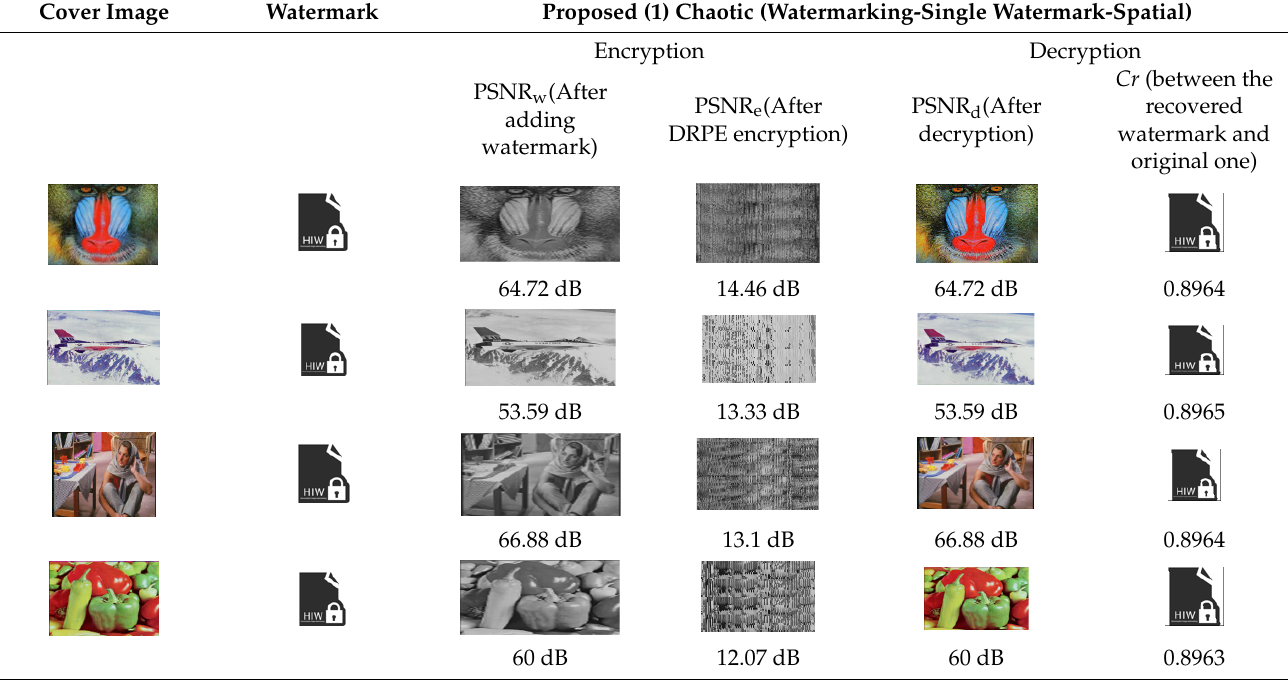
Table 7. Results of the first proposed technique based on